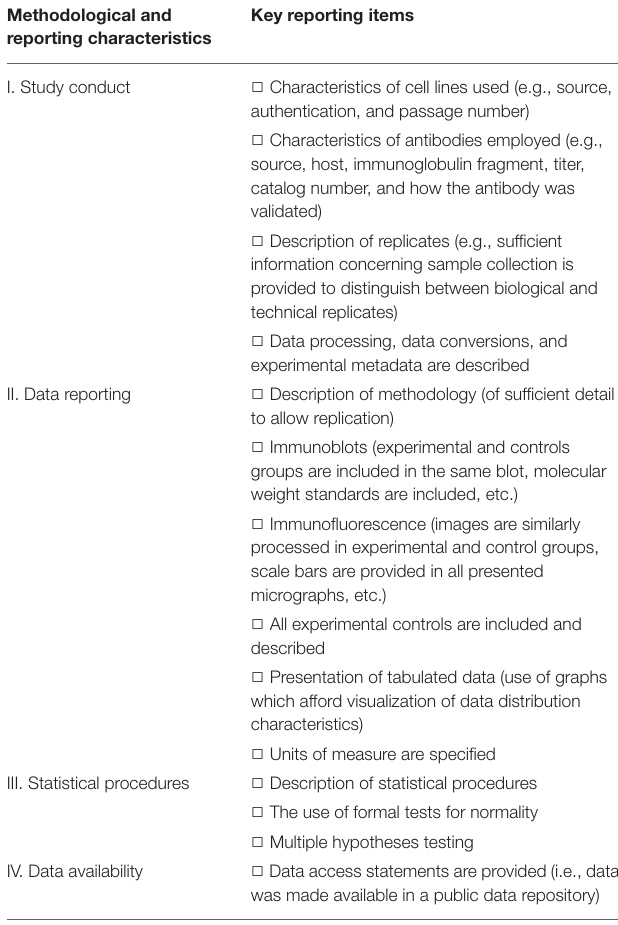
TABLE 1 | Molecular and cellular studies ( in vitro